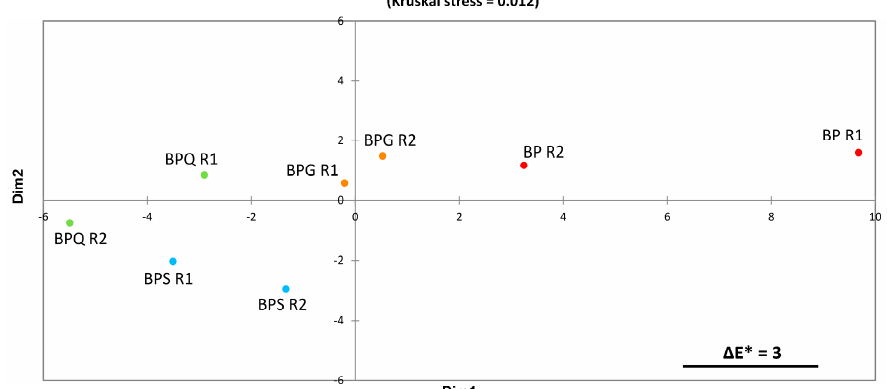
Figure 3. Colorimetric differences between samples obtained by MDS of the Δ E* distance matrix. The segment represented in the bottom right corner represents the distance corresponding to Δ E* of 3, which is the average human difference threshold for colour differences [38]. R1 and R2 correspond, respectively, to the two replicates of each condition. BP: bioprotection, BPG: bioprotection and gall nut tannin addition, BPQ: bioprotection and quebracho tannin addition, BPS: bioprotection and SO 2 addition.